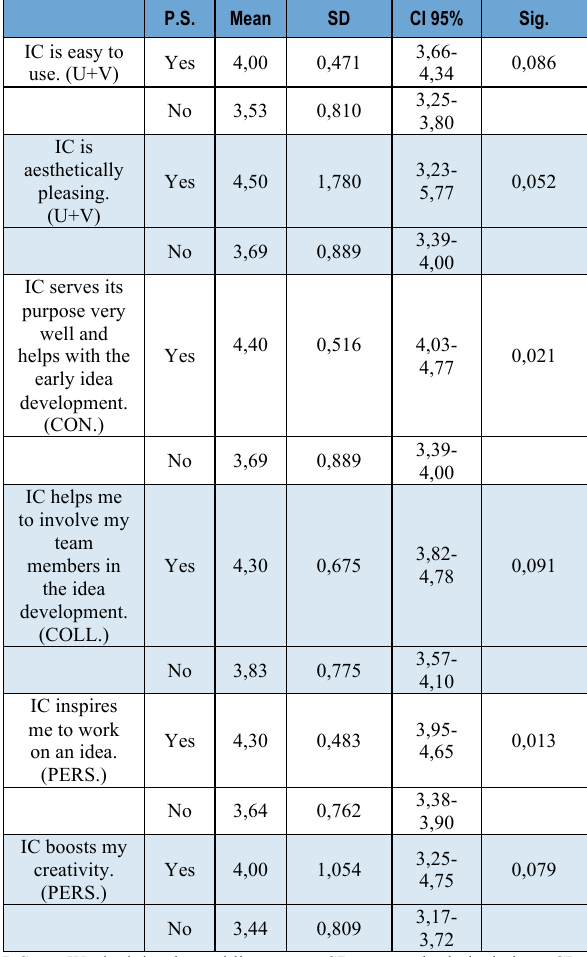
Table 1. List of statements that significantly differ for researchers who have worked in the public sector (Yes, N=10) and those without this experience (No, N=36).